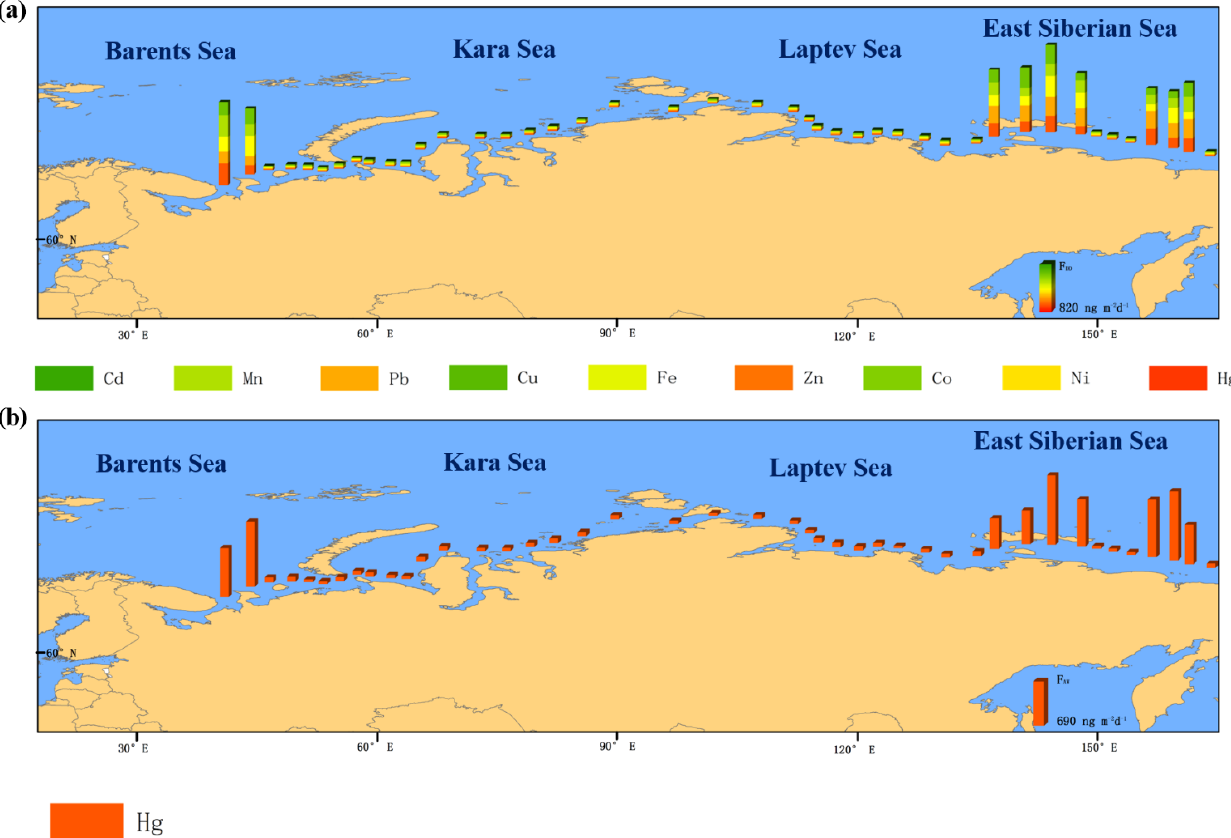
Figure 3. Measured atmosphere–ocean exchange of heavy metals. (a) Fluxes of dry deposition for nine heavy metals; (b) fluxes of net diffusive air–water exchange for Hg. In panel (a) , the colored bars represent the sum of nine heavy metals. In panel (b) , the downward bars represent the net deposition into the ocean, and the upward bars represent the net volatilization of